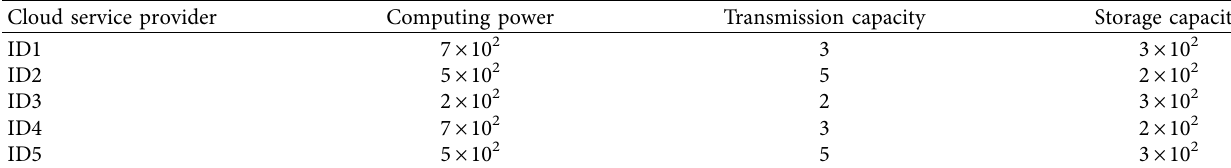
Table 1: Evaluation indicators of cloud providers (unit/10 4 ).